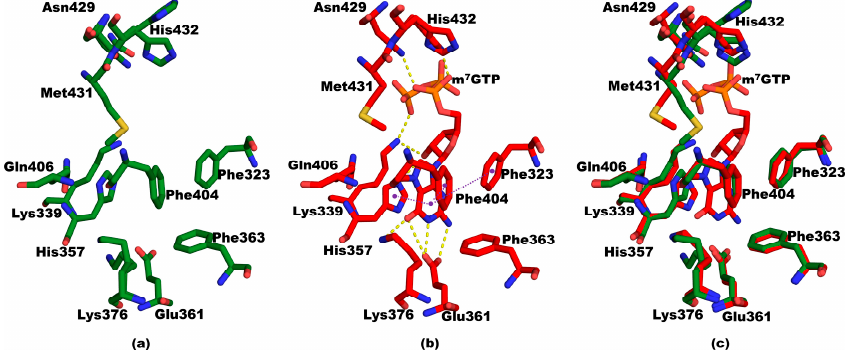
Figure 2. ( a ) The cap-binding site in PB2cap from A/California/07/2009 (H1N1) (PDB code: 5EG8) (forest). ( b ) The cap-binding site in mutant PB2cap from A/California/07/2009 (H1N1) bound to m 7 GTP (PDB code: 5EG7) (red). ( c ) 5EG8 (forest) aligned with 5EG7 (red). Hydrogen bonds are shown with dotted yellow lines, and π - π force interactions are shown with dotted purple lines